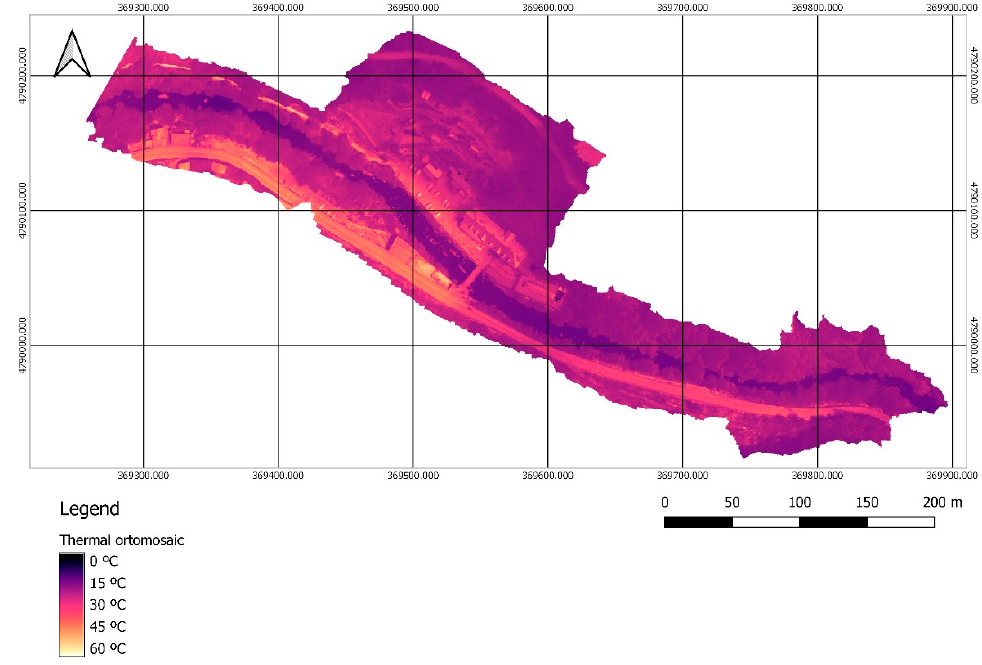
Figure 7. Thermal orthomosaic for the surface temperature, with a GSD of 6.26 cm/px.